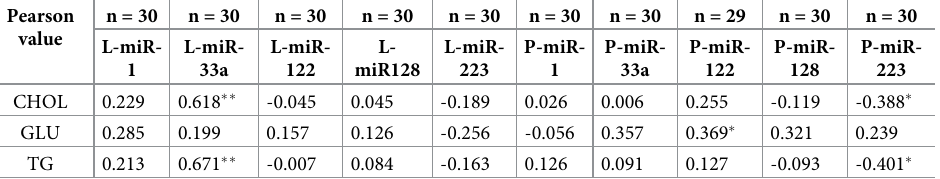
Table 5. Correlations of plasmatic parameters, miRNAs expression in the liver, and miRNAs level in the plasma of rainbow trout. Pearson value